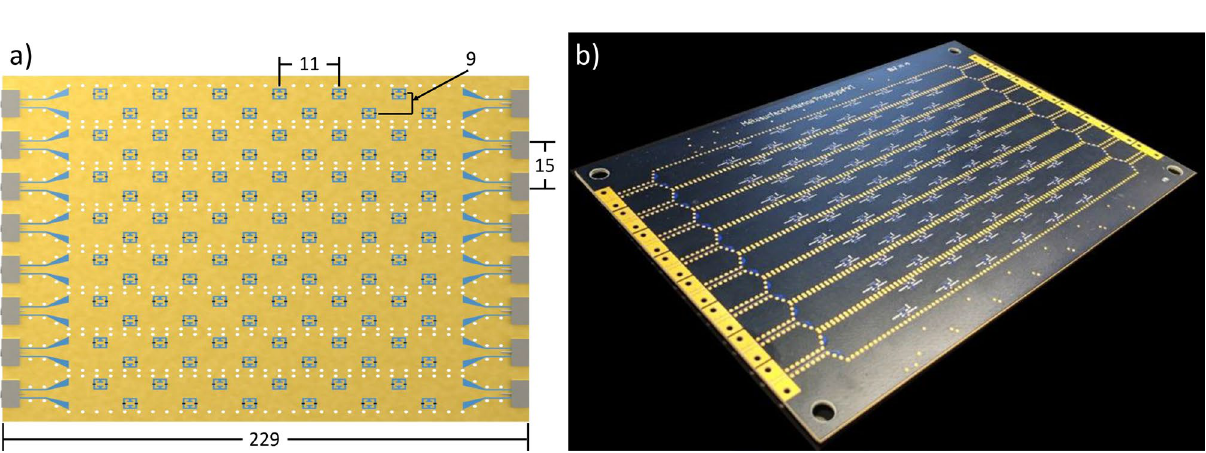
Figure 4. Nyquist metasurface antenna layout, ( a ), with dimensions in mm. ( b ) Shows a picture of the